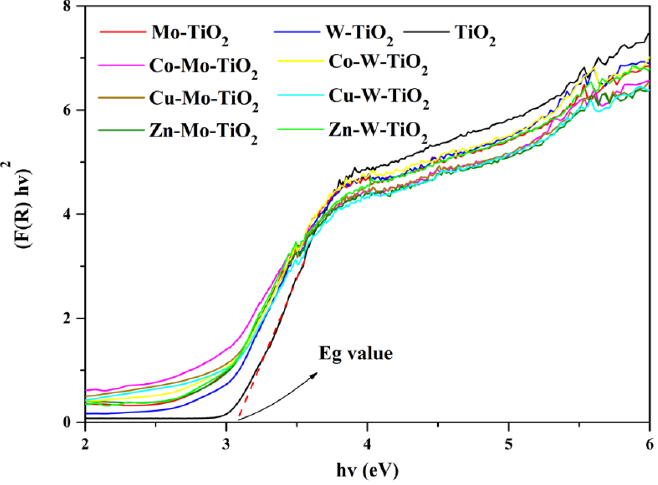
Figure 16. Tauc plot of all